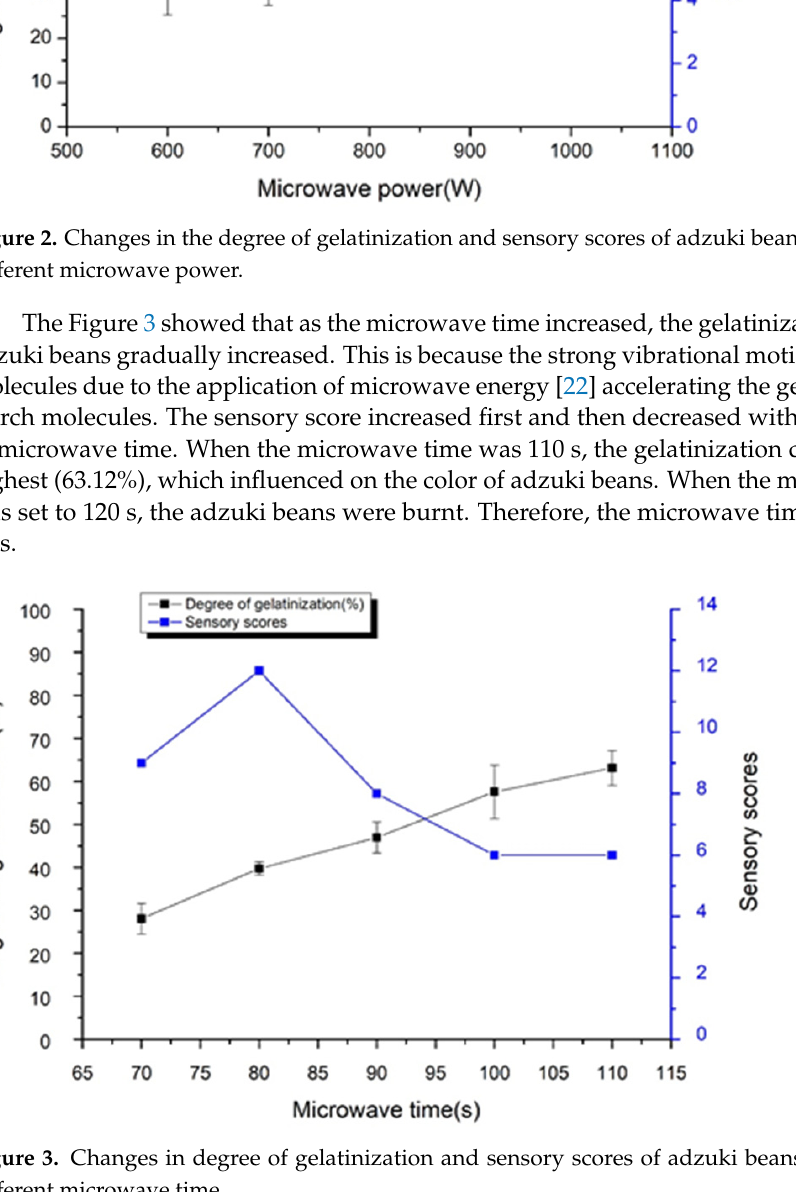
Figure 2. Changes in the degree of gelatinization and sensory scores of adzuki beans pre-cooked of different microwave power.